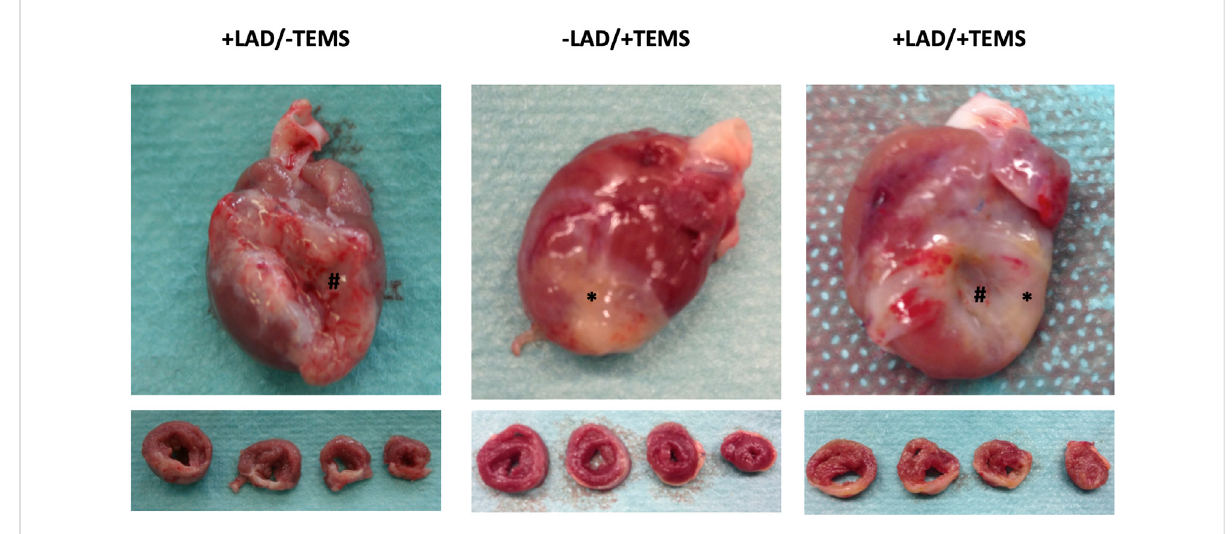
FIGURE 3 Macroscopic appearance of explanted heart specimens after LAD-ligation and TEMS implantation. Representative images of explanted whole heart and sliced specimens 4 weeks after either LAD-ligation, TEMS implantation and LAD-ligation plus TEMS-implantation. Region of myocardial infarction as wells TEMS scaffold was clearly distinguishable in all specimens. #, region of myocardial infarction; *, TEMS